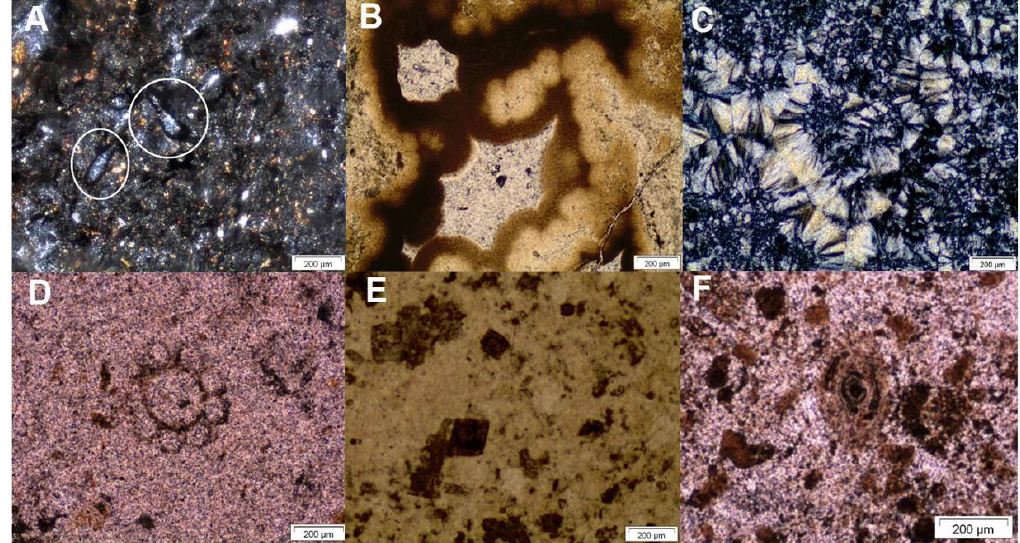
Figure 3. Microscopic view of each group. A. and D. Charophyte algae; B. Opal and carbonates; C. Microquartz and chalcedony; E. Rhombohedral dolomite crystals; and F. Miliolida. Images A and C are crossed polariser views, while the rest are seen in single polariser view. See below for further